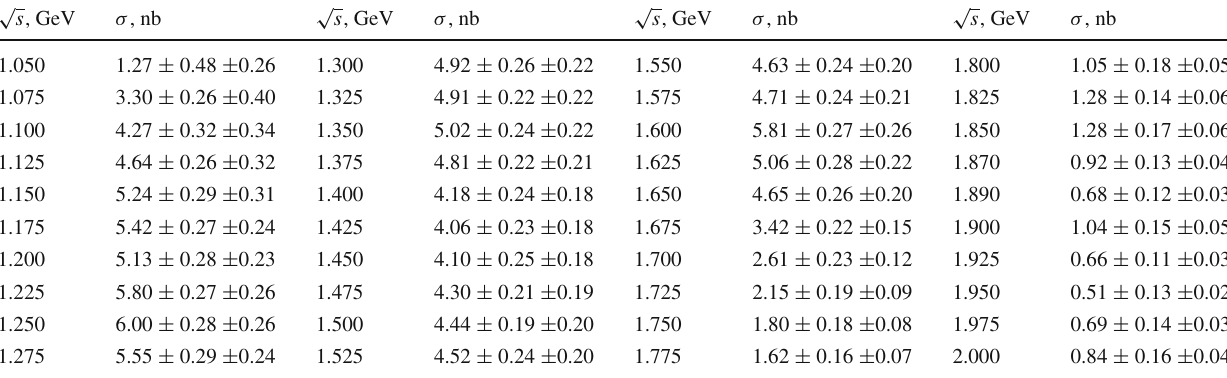
√ Table 2 The c.m. energy ( s ) and Born cross section ( σ ) for 40 energy points of the 2011 scan. The quoted errors are statistical and systematic, respectively √ s , GeV σ ,